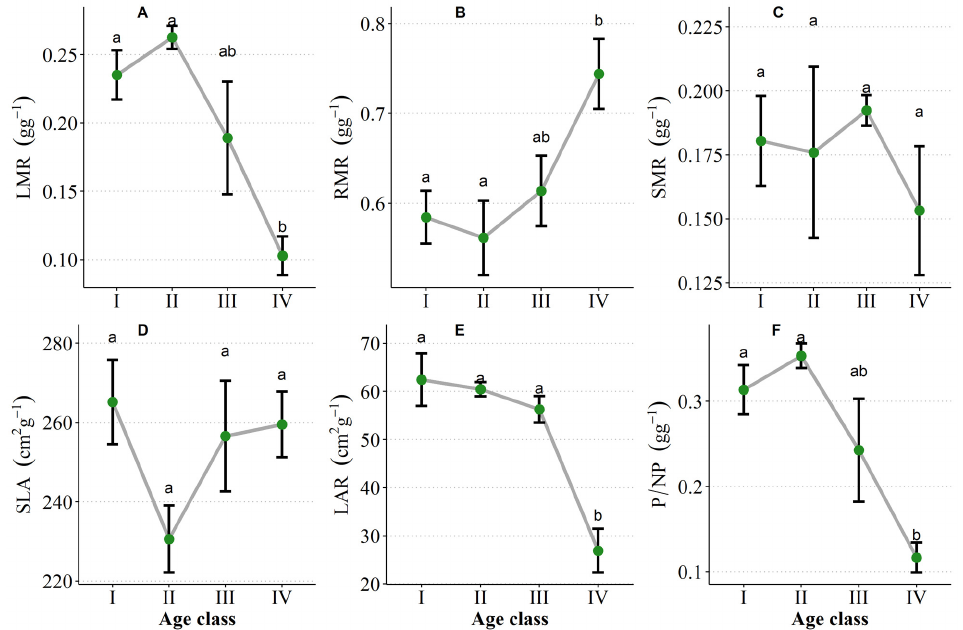
Figure 5. Changes of biomass allocation with the increase of seedling age of Quercus acutissima . ( A ) LMR, leaf mass ratio; ( B ) RMR, root mass ratio; ( C ) SMR, stem mass ratio; ( D ) SLA, specific leaf area; ( E ) LAR, leaf area ratio; ( F ) P/NP, photosynthetic tissues/non-photosynthetic tissues. Different letters above error bars show significant differences.